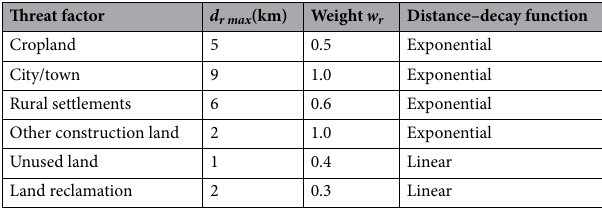
Table 1. Threat factors and related